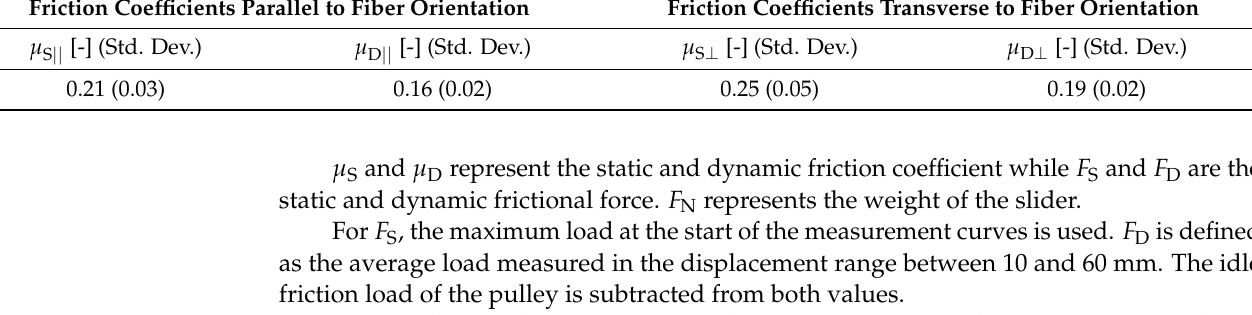
Table 4. Coefficients of friction determined between pressed PP-GF plate specimens and the standard slider made from